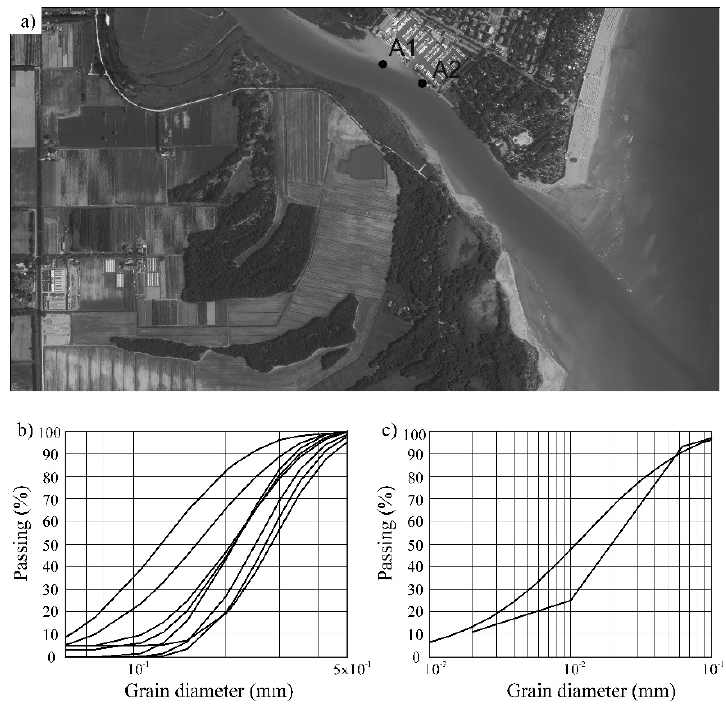
Figure 9. ( a ) Position of the cores used to deduce sediment data; ( b ) granulometric distribution curves of bed sediments along the centre-line of the river; and ( c ) granulometric distribution curves of bed sediments at the shore line (cores A1 and A2).